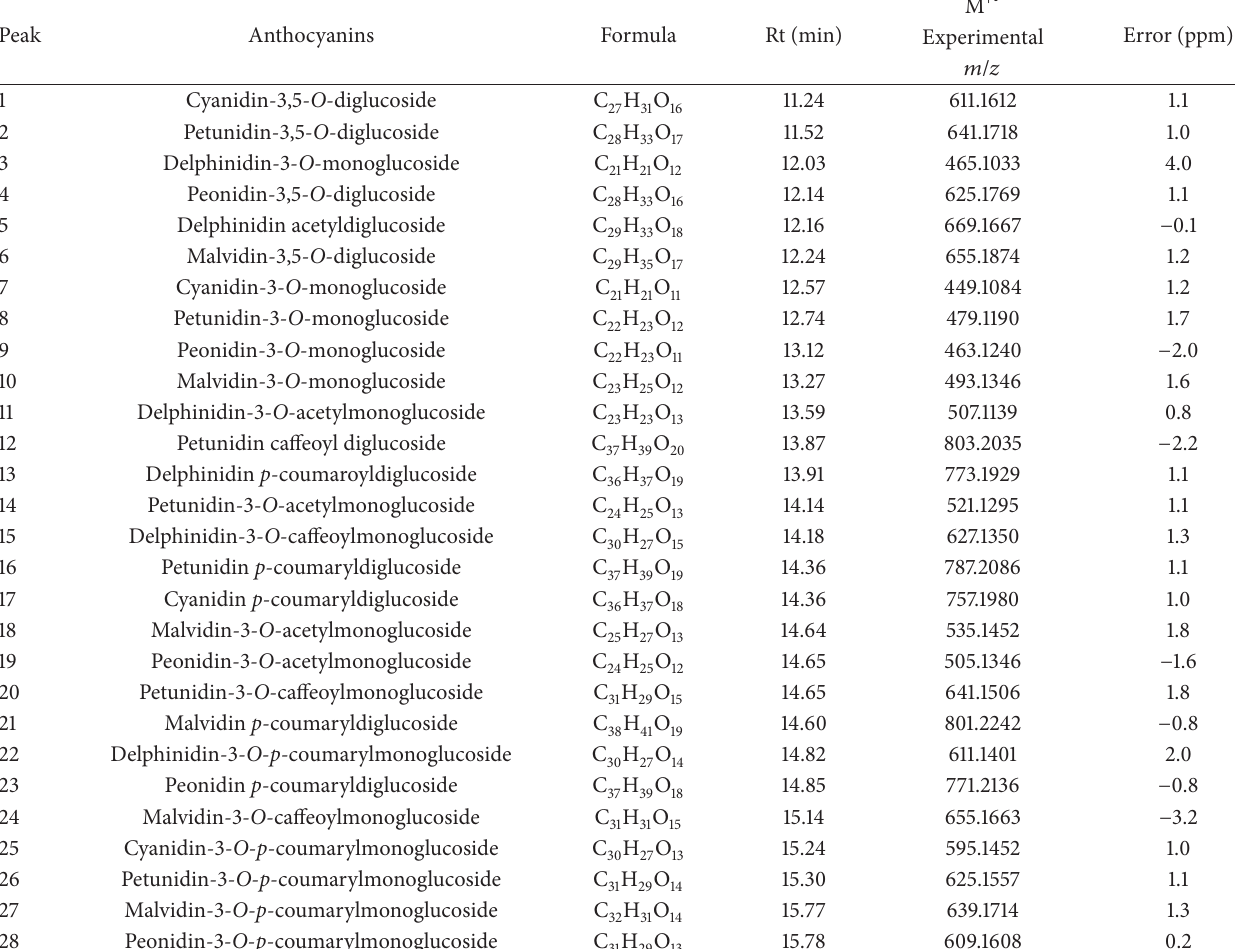
Table 2: Anthocyanin M +∙ ions identified in Clinton grape extract. Identification scores calculated with respect to the theoretical mass are reported. Numbers correspond to the peaks of chromatogram in Figure 4.